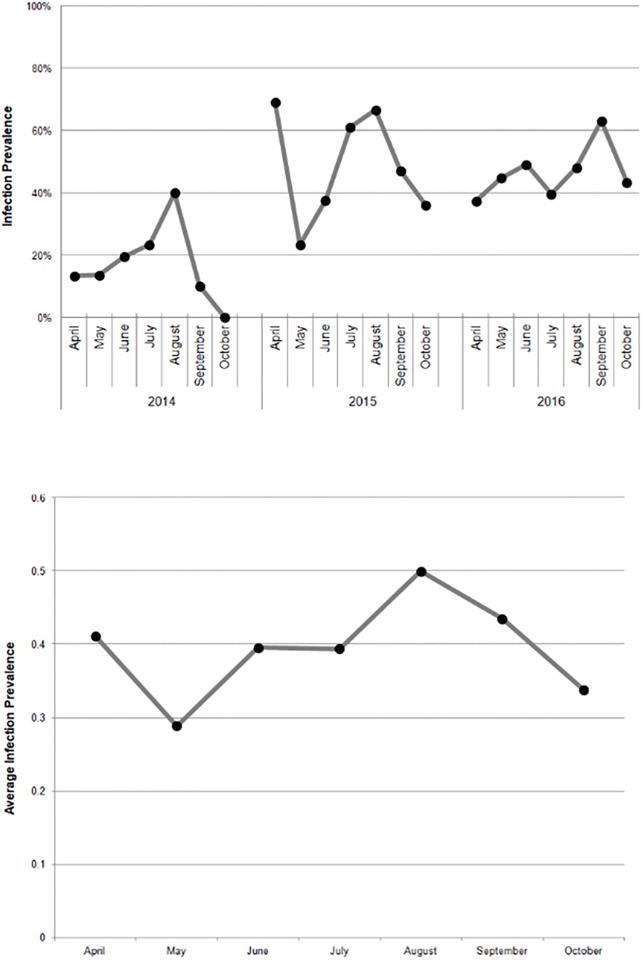
Monthly infection prevalence 2014–2016.The percent of infected crabs (infection prevalence) is graphed for each month where samples were collected from the Maryland coastal bays. Figure modified from [19]. (A) Each individual year is shown in chronological order. (B) Pooled dataset.